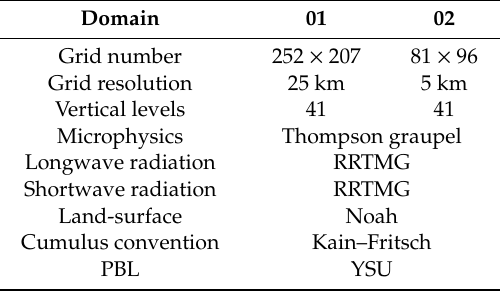
Table 1. Domain configuration and parameter settings of the WRF model.